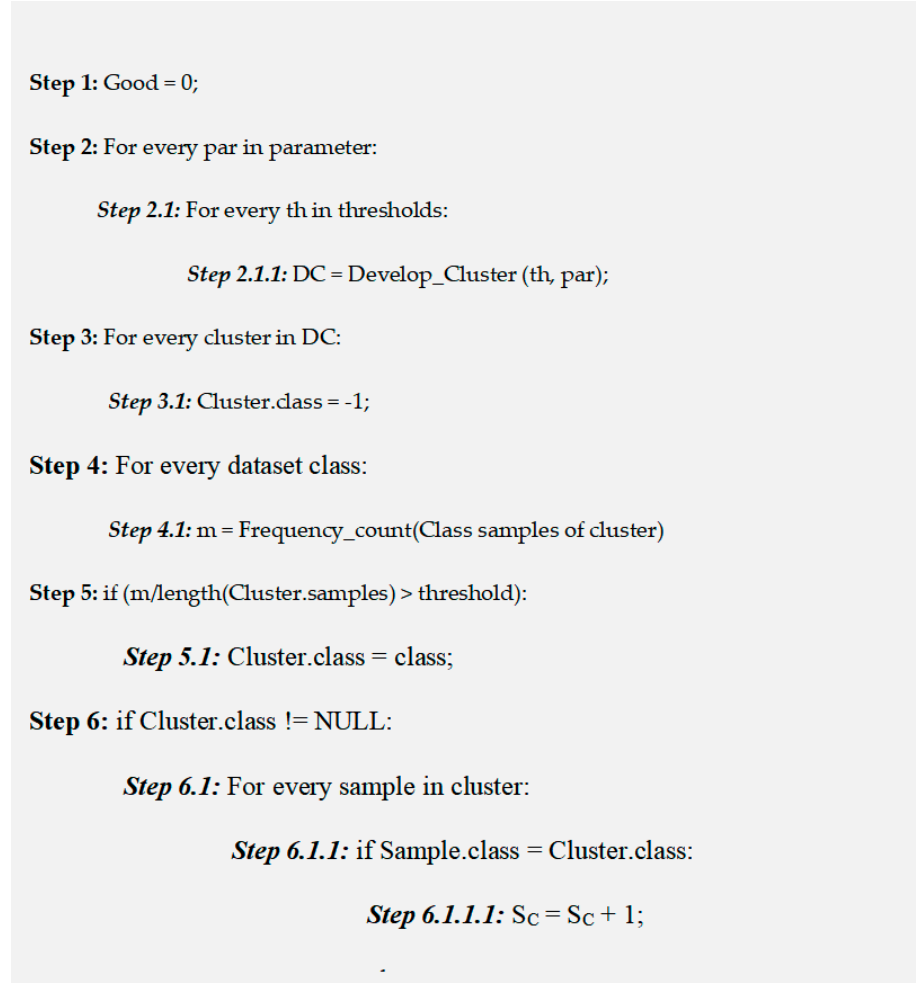
Figure 16. Pseudo code for parameter adjustment and generation in Improved decision tree model.